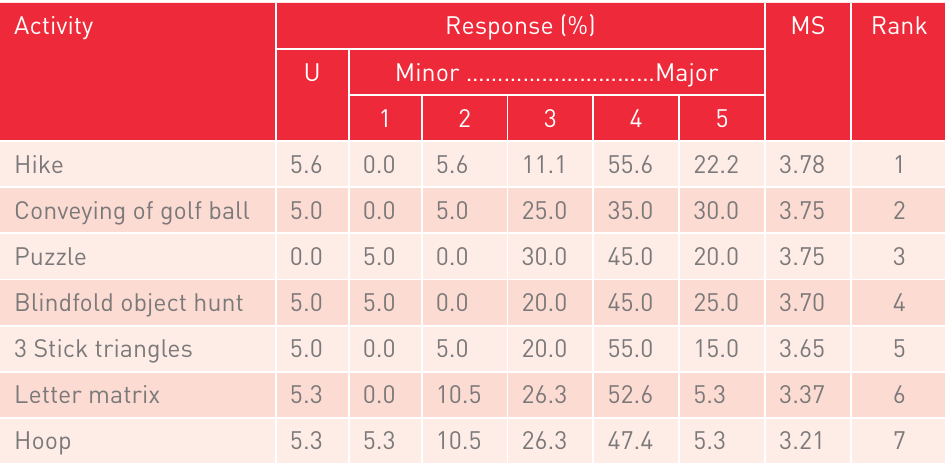
Extent to which the team building activities enhanced participants’ ability to